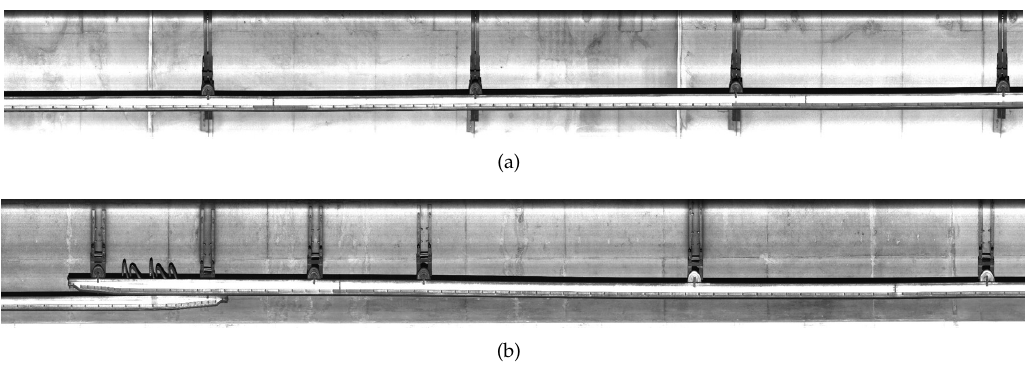
Figure 2. Acquired images: ( a ) the 5-th and ( b ) 20-th